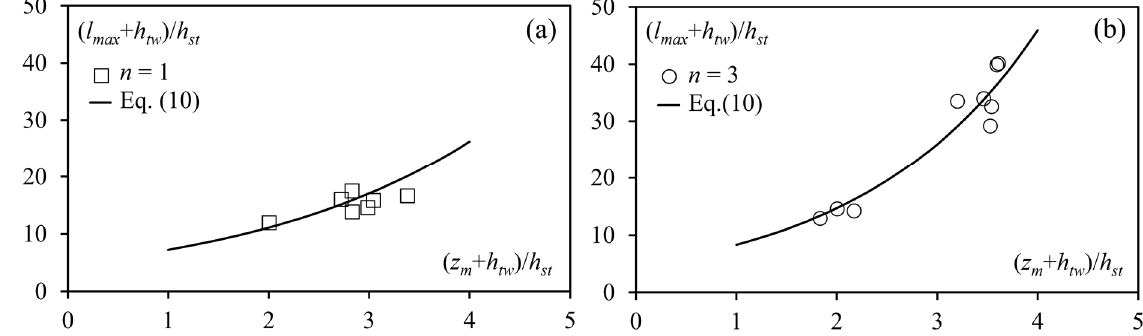
Figure 13. ( l max + h tw )/ h st vs. ( z m + h tw )/ h st along with the plot of Equation (10) for ( a ) n = 1 and ( b ) n = 3.